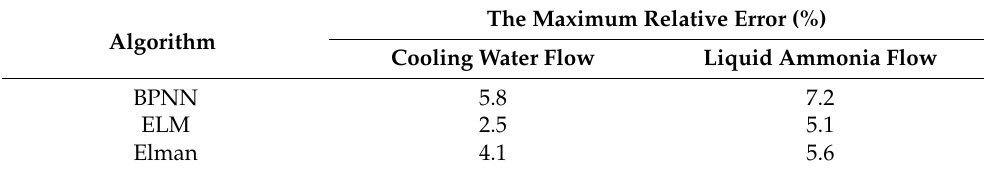
Table 3. The prediction results of three different prediction algorithms.